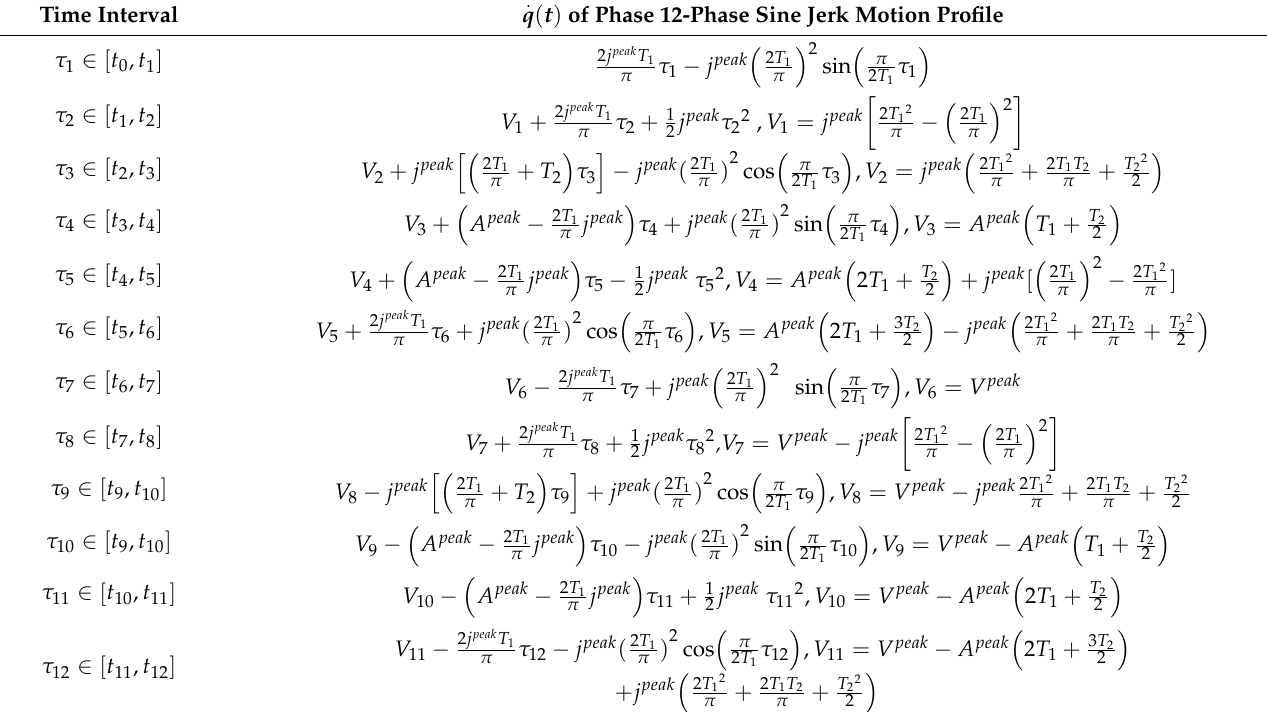
Table 1. Piecewise function of the angular velocity, Time Interval